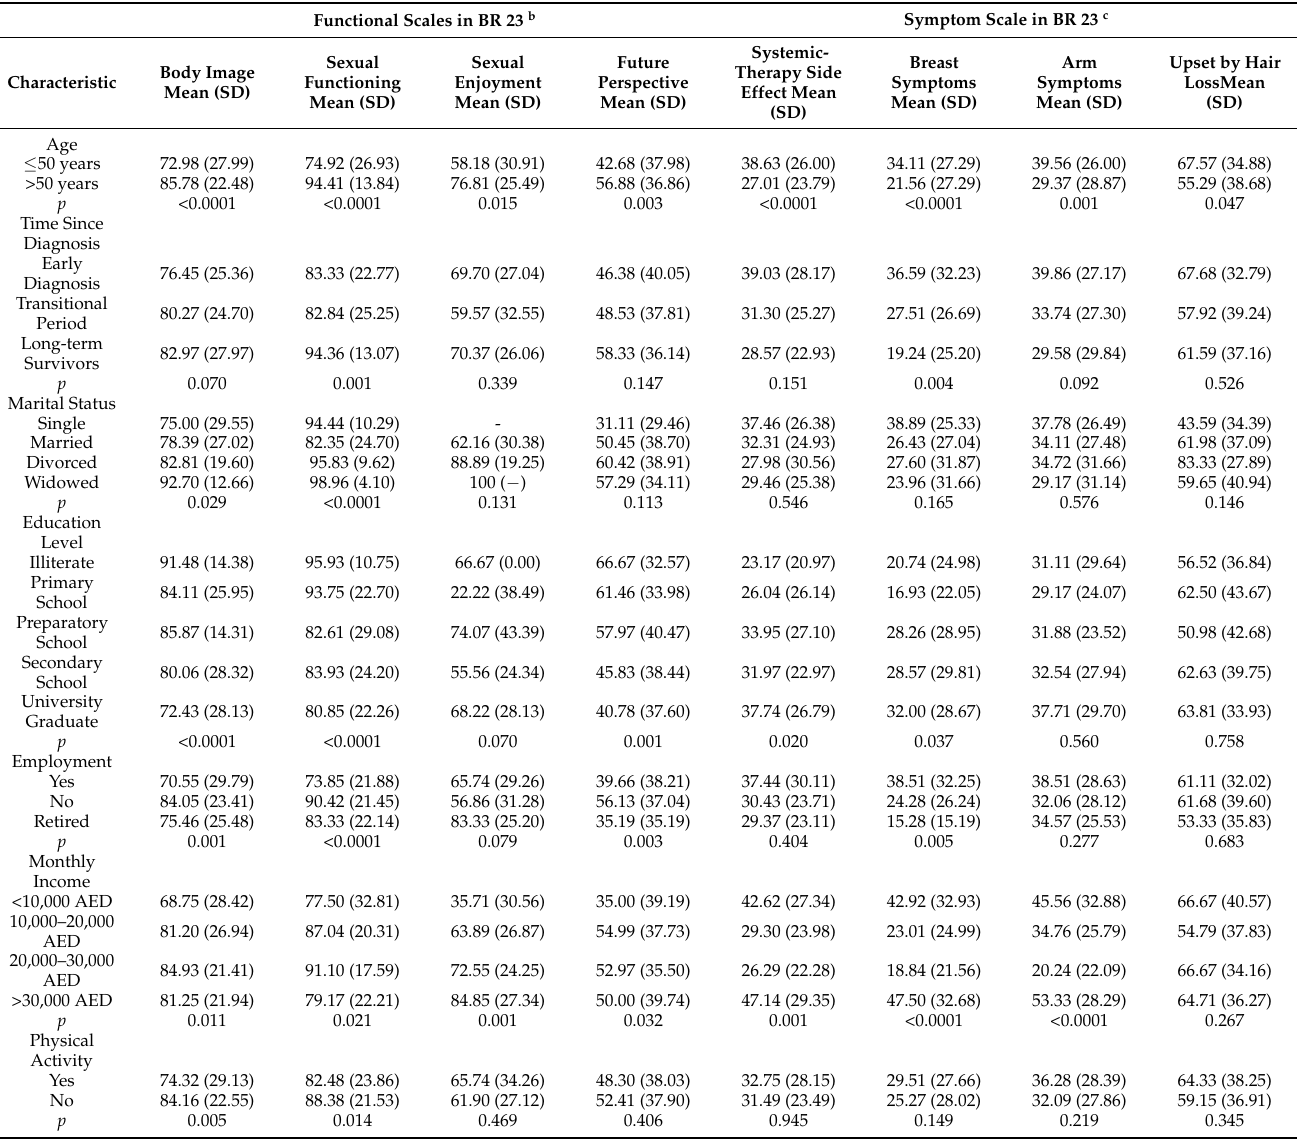
Table 4. Functional and symptom scales on the QLQ-BR23 by independent variables (N = 250) a . Functional Scales in BR 23 b Symptom Scale in BR 23